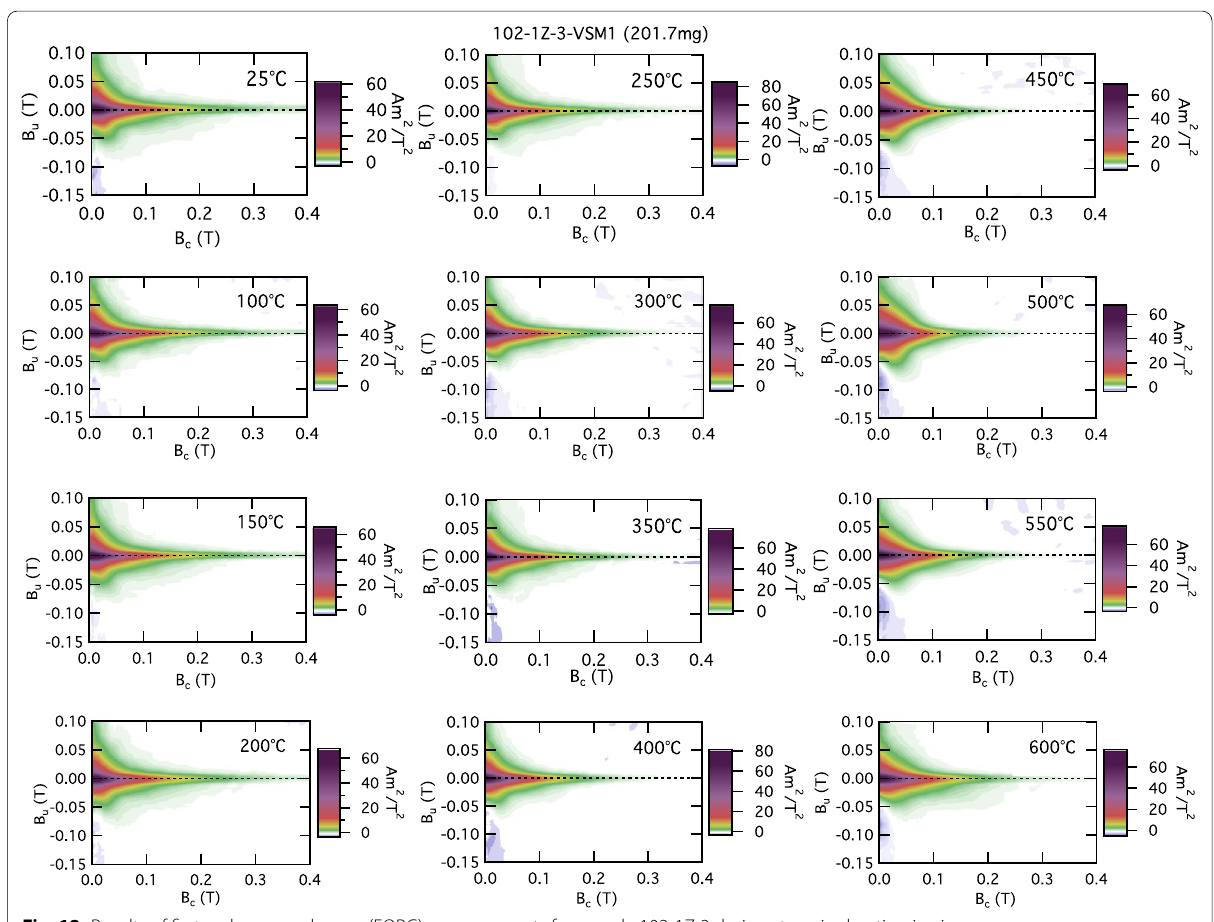
Fig. 12 Results of first-order reversal curve (FORC) measurements for sample 102-1Z-3 during stepwise heating in air